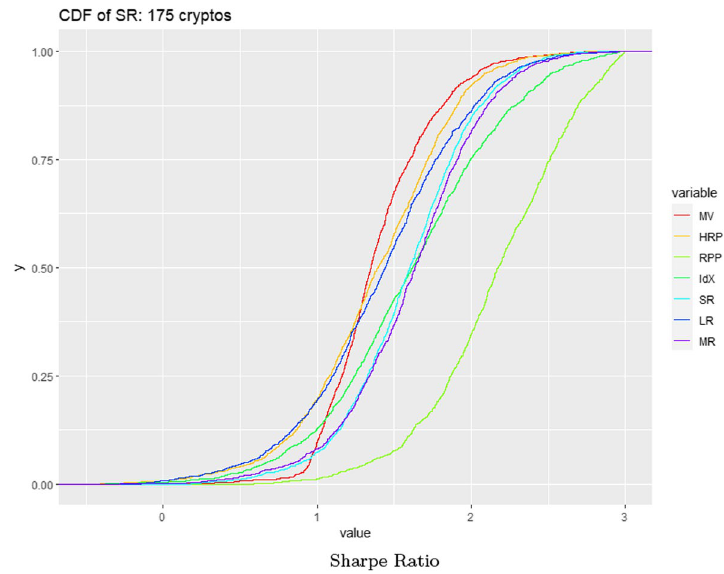
Fig. 5 Cumulative distribution of annualized sharpe ratio ( SR ann ) of the simulations (1500 random investing paths) for 175 higher marketcap cryptos